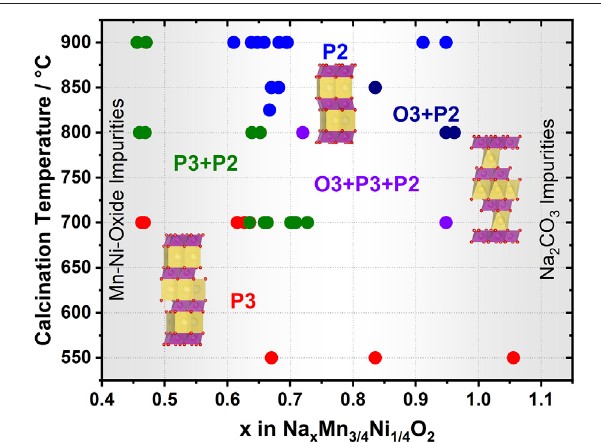
FIGURE 2 | Phase diagram obtained when varying the calcination temperature and the sodium content. The Mn/Ni ratio was kept constant by using the same Mn 3/4 Ni 1/4 (OH) 2 precursor. Re fi ned crystal structures are visualized by red dots for P3, blue dots for P2, green dots for P3-P2, dark blue dots for O3-P2 mixtures and purple dots for mixtures of O3-P3-P2. The sodium content ( x -axis) was derived from ICP-OES analysis, phase analysis was performed via Rietveld re fi nement of XRD